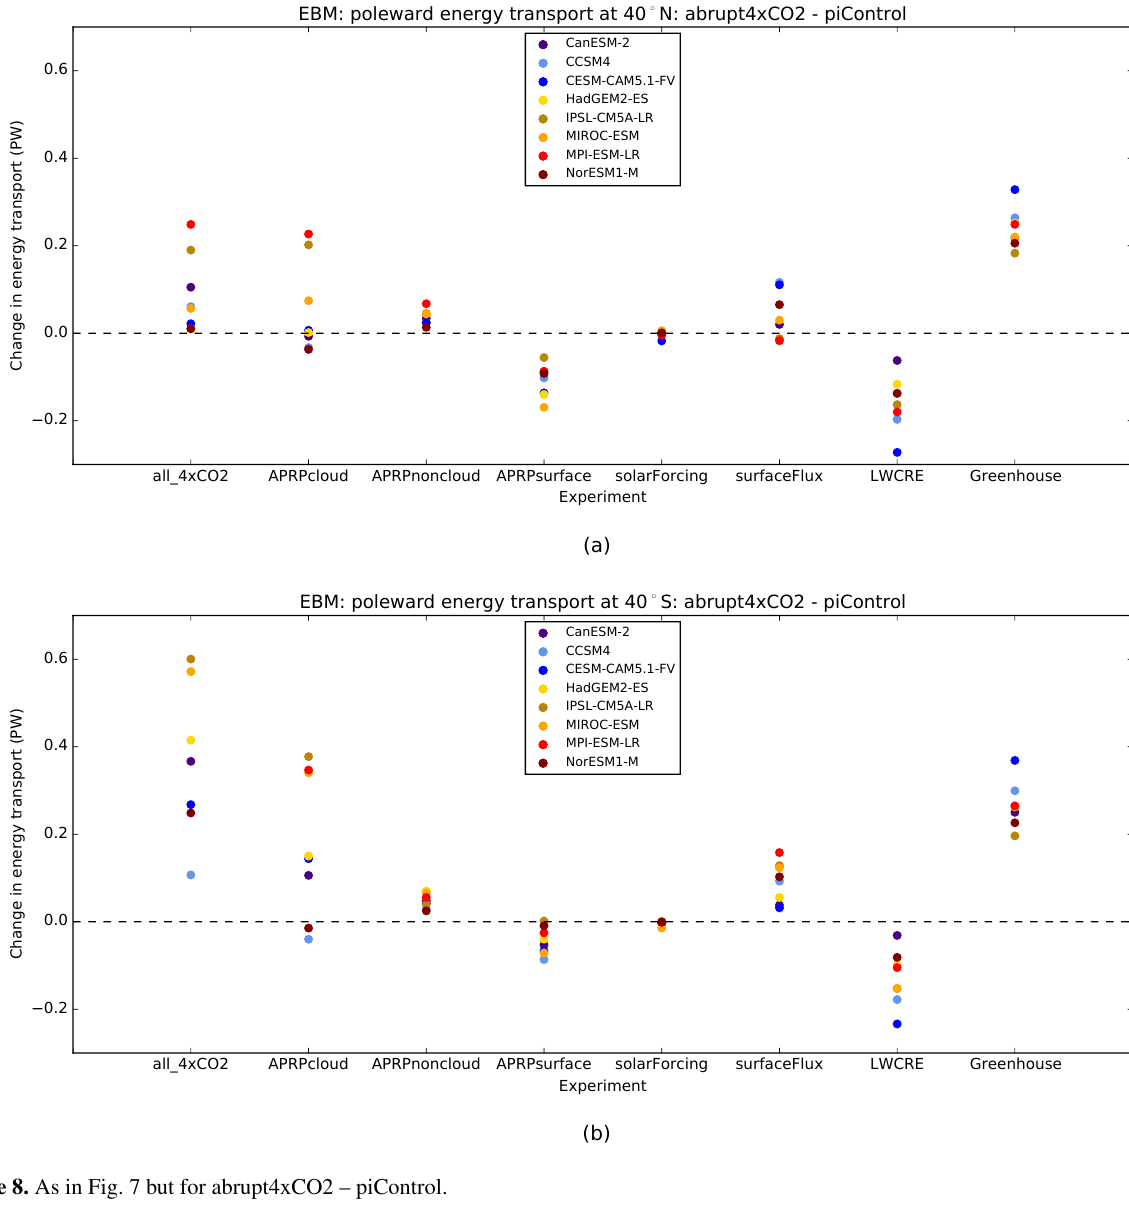
port, similar to the same experiment for G1. SW cloud feed- backs (APRPcloud experiment) are the largest contributor to the intermodel spread, followed by LW cloud feedbacks.